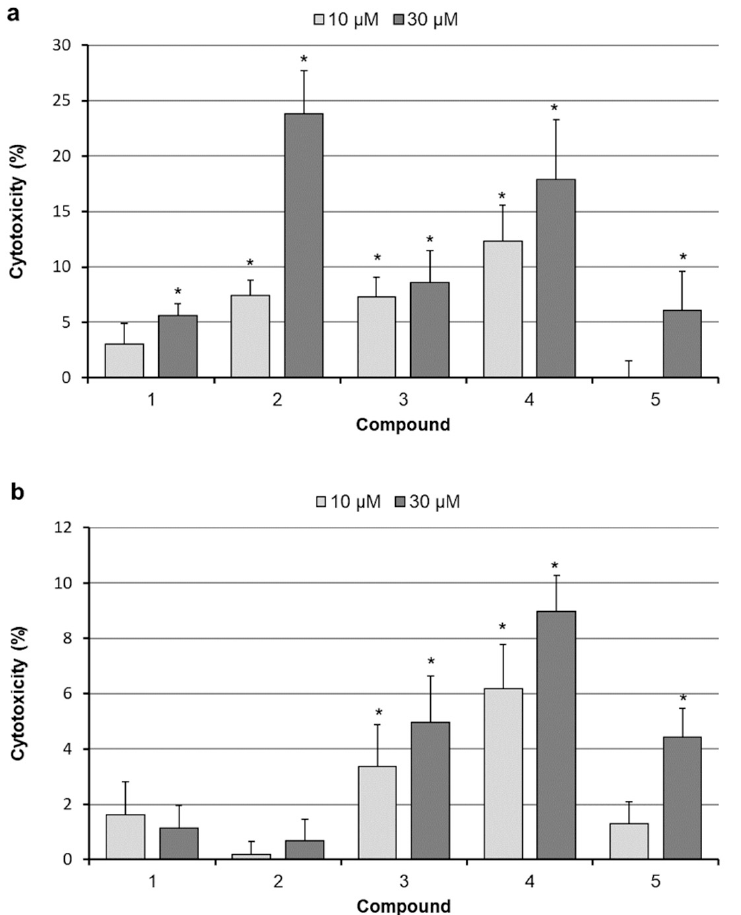
Figure 3. Effect of 24 h exposure to betulin and its derivatives on LDH release from SK-BR-3 ( a ) and MCF-7 ( b ) cells; the results are shown as percentage of maximal LDH release induced by cell lysis; each bar represents the mean ± SD; * p < 0.05 compared with control.